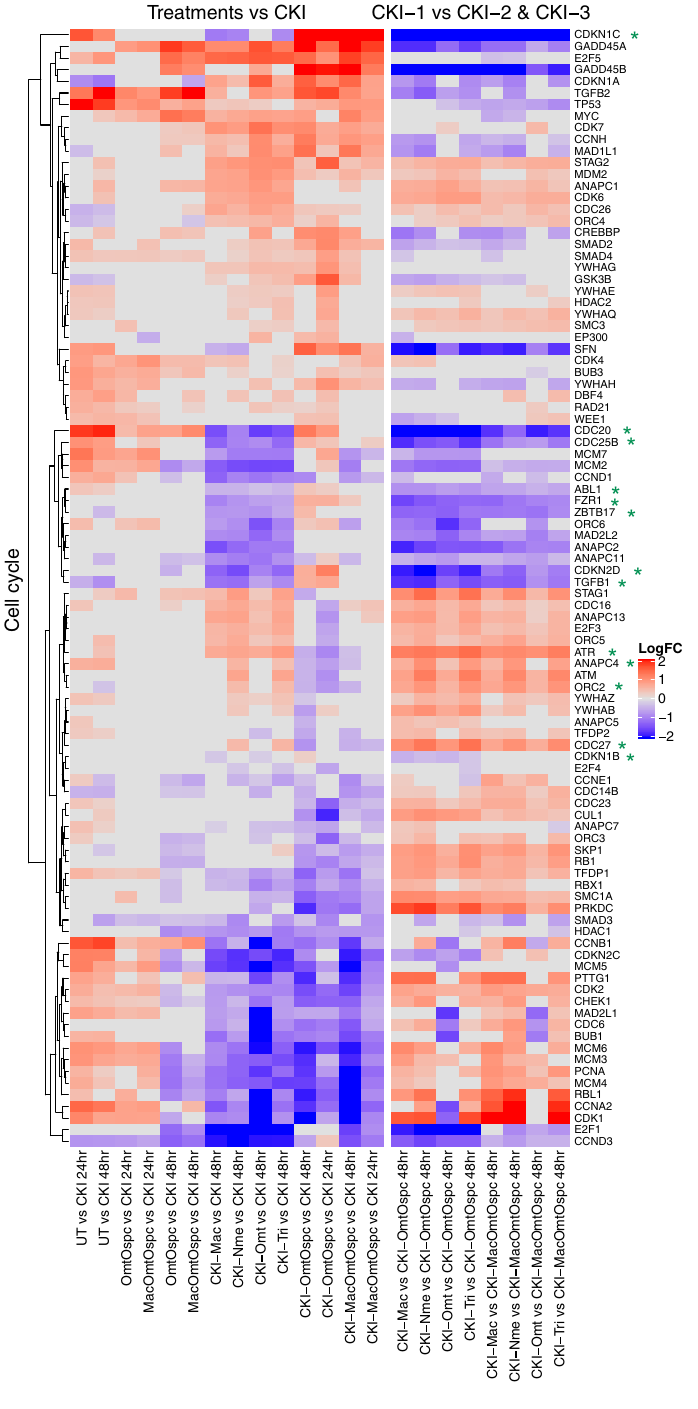
Figure 7. Differential gene expression profiles of all treatments for Cell-Cycle pathway. The left panel shows comparison of subtractive fraction treated cells against CKI treatment and the right panel shows comparison of single compound subtractive fraction treated cells against the treatments for two and three compound subtractive fractions. Asterisks in green show a subset of genes that have opposite changes in gene expression across